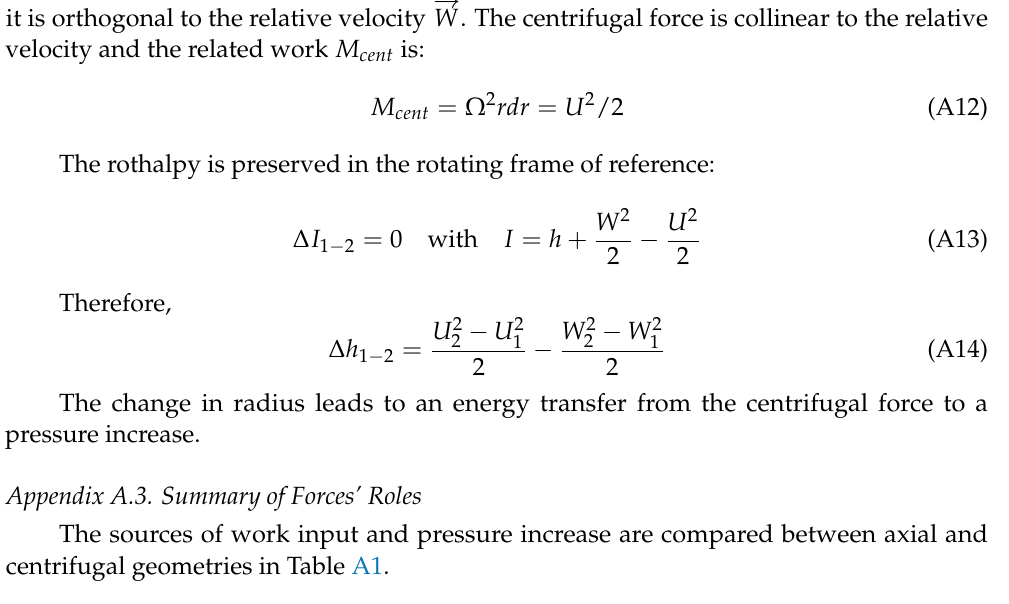
Table A1. Comparison of sources of work input and pressure increase between axial and centrifugal